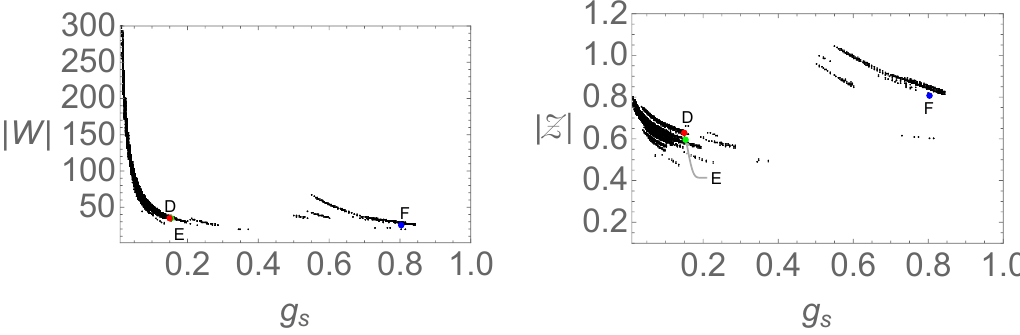
Figure 4 . Numerical results for the absolute values of the (cid:13)ux superpotential j W j and jZj = e K= 2 j W j on each of the (cid:13)ux vacua depicted in (cid:12)gure